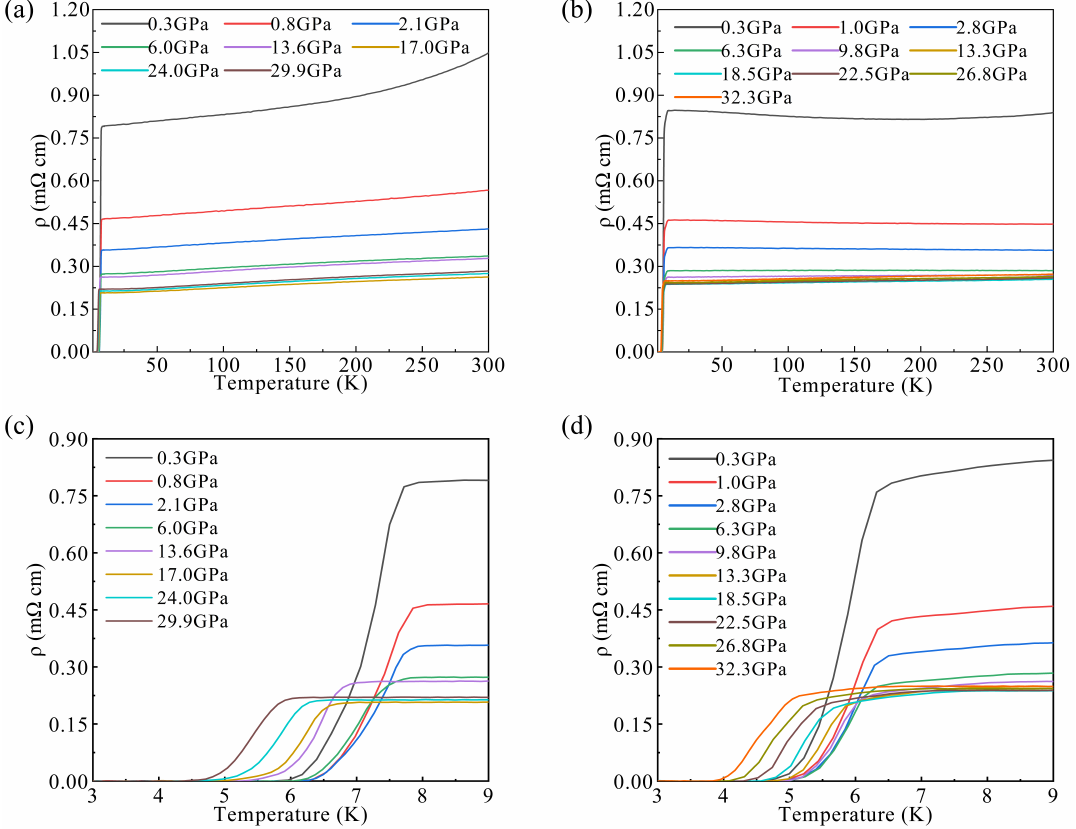
Figure 2. Mesh of the model used for the FEM calculation of the J-integral for CRB specimens. Figure 3. Electrical resistivity of ZrRuAs ( a ) and HfRuP ( b ) as a function of temperature at various pressures. Temperature-dependent resistivity of ZrRuAs ( c ) and HfRuP ( d ) in the vicinity of the superconducting